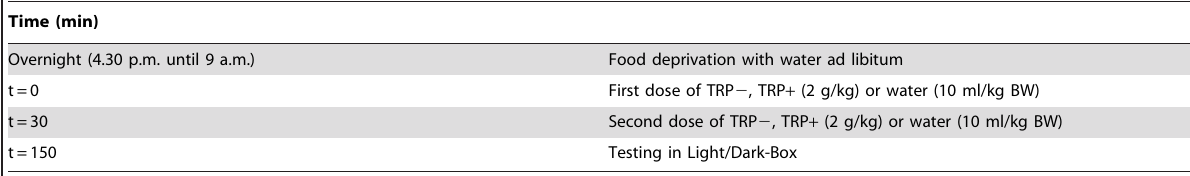
Table 1. Time Course of Behavioral Experiment.